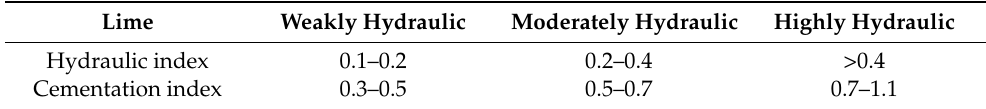
Table 1. Classification of lime according to hydraulic and cementation indices. Lime Weakly Hydraulic Moderately Hydraulic Highly